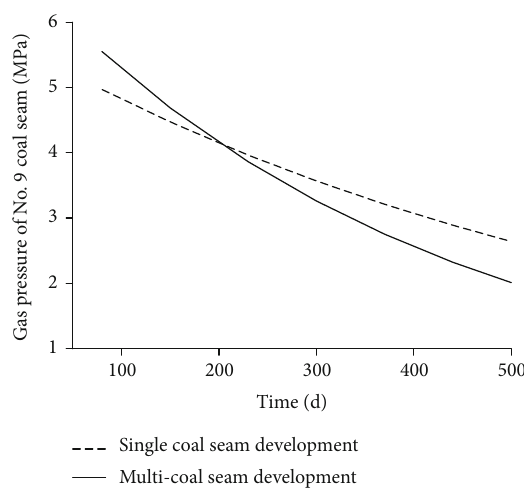
Figure 9: E ff ect of multicoal seam development on gas pressure. Figure 10: E ff ect of multicoal seam development on water